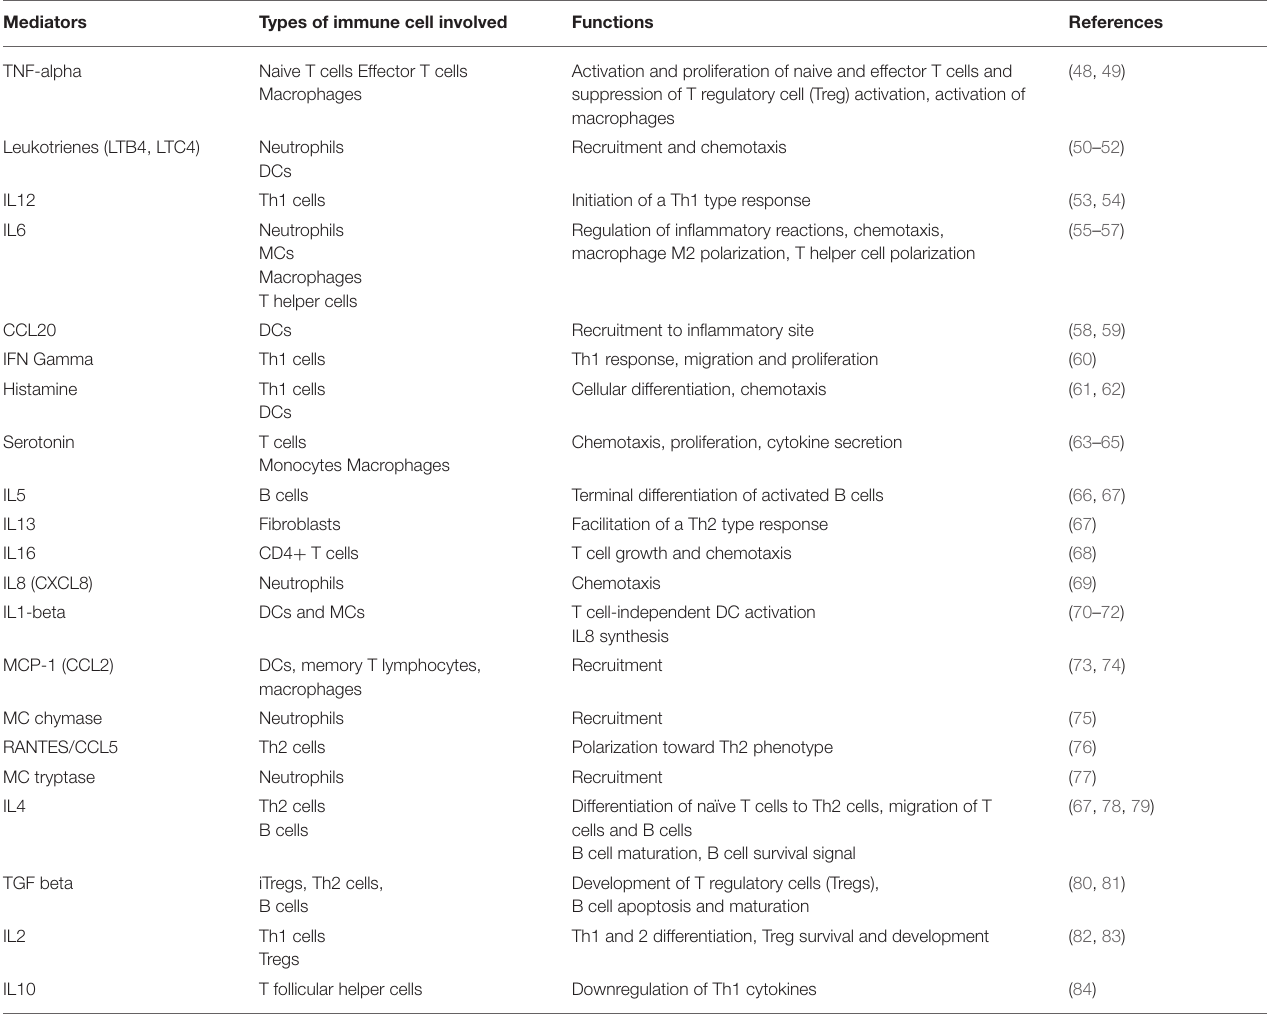
TABLE 1 | MC-secreted major mediators in immune